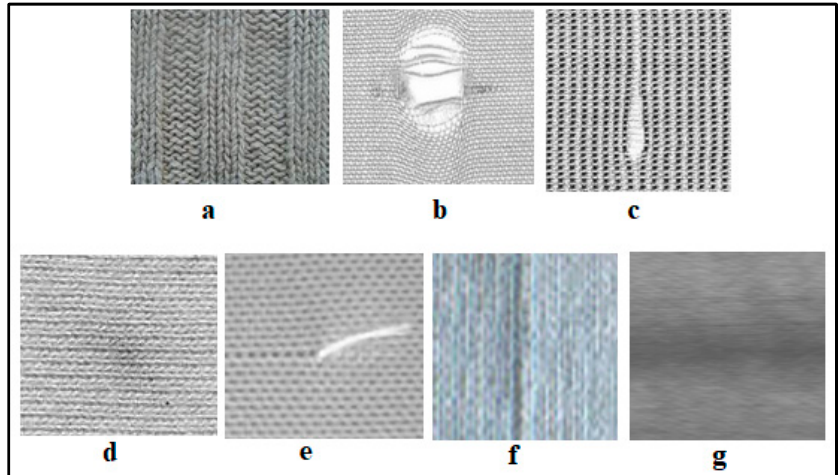
Figure 3. Examples for defect types: ( a ) nondefective; ( b ) hole; ( c ) weave; ( d ) stain; ( e ) thread; ( f ) knitting; ( g ) shaded.